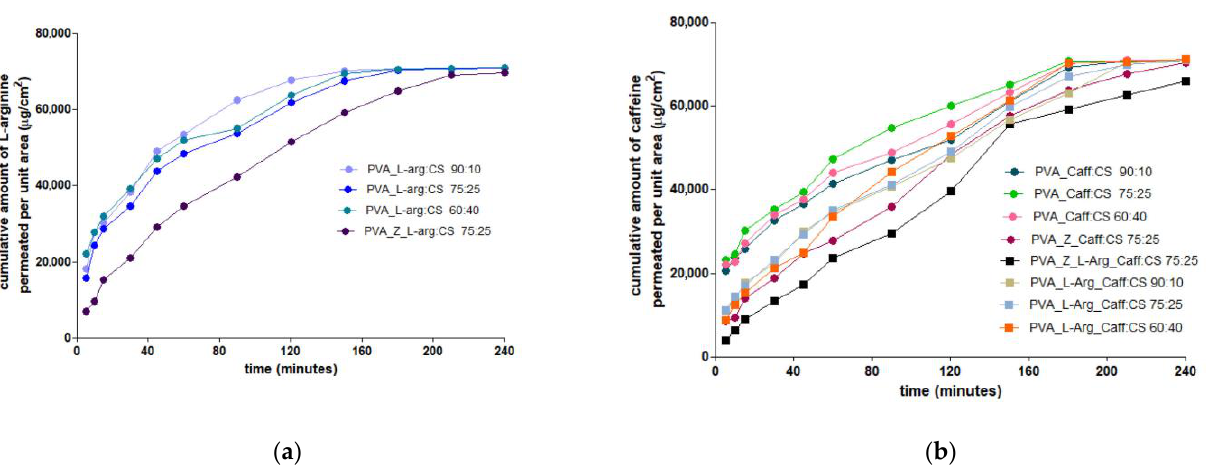
Figure 5. In vitro permeation of ( a ) L-arg and ( b ) Caff from hydrogels across the chicken skin membrane.